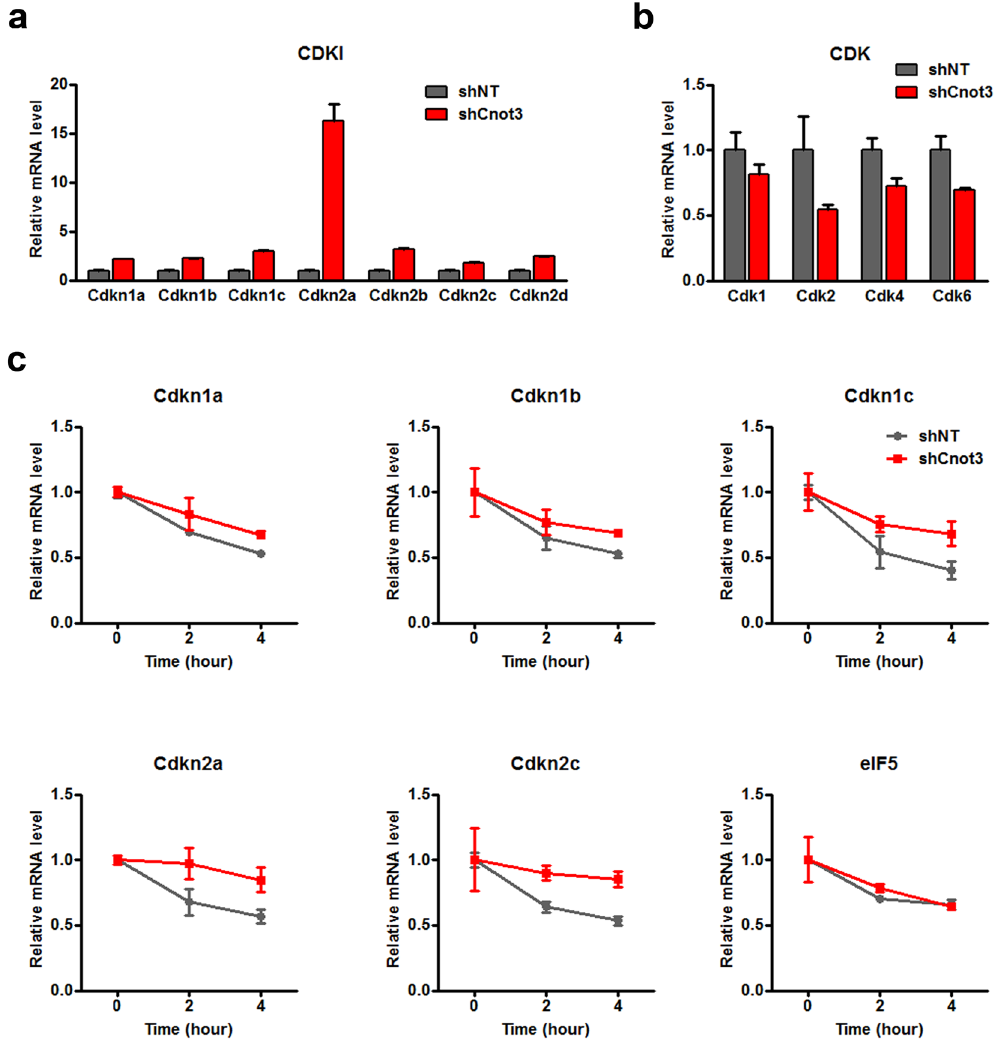
mean ± SEM from three independent